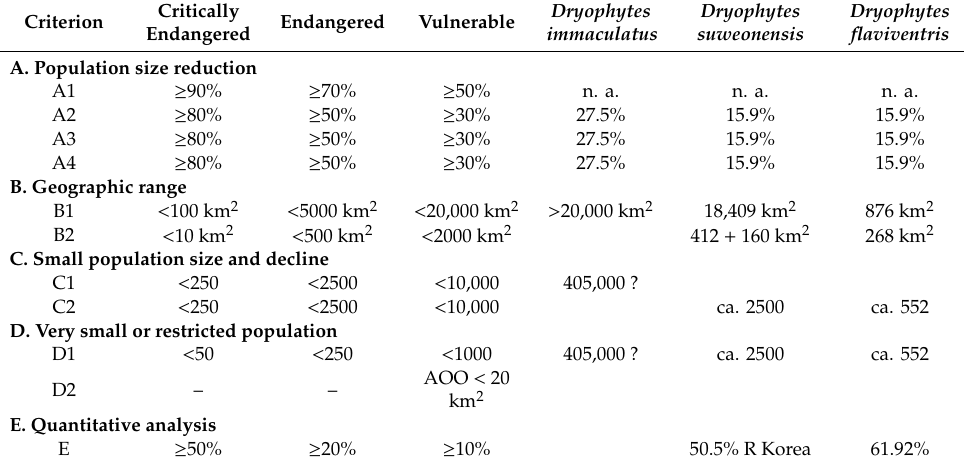
Table 1. Details of values used for the assessment. The three first row are the threshold provided in [37]. The values provided for the three Dryophytes species need to be read in conjunction with the corresponding time window provided in [37] and in the text (full guidelines: www.iucnredlist. org / resources / redlistguidelines). The data provided for each criterion is placed in the corresponding subcriteria based on variables explained in text. The population size for Dryophytes immaculatus is expressed with a “?” to denote the uncertainty of this value. Rows are left empty when the data for the corresponding criterion is not